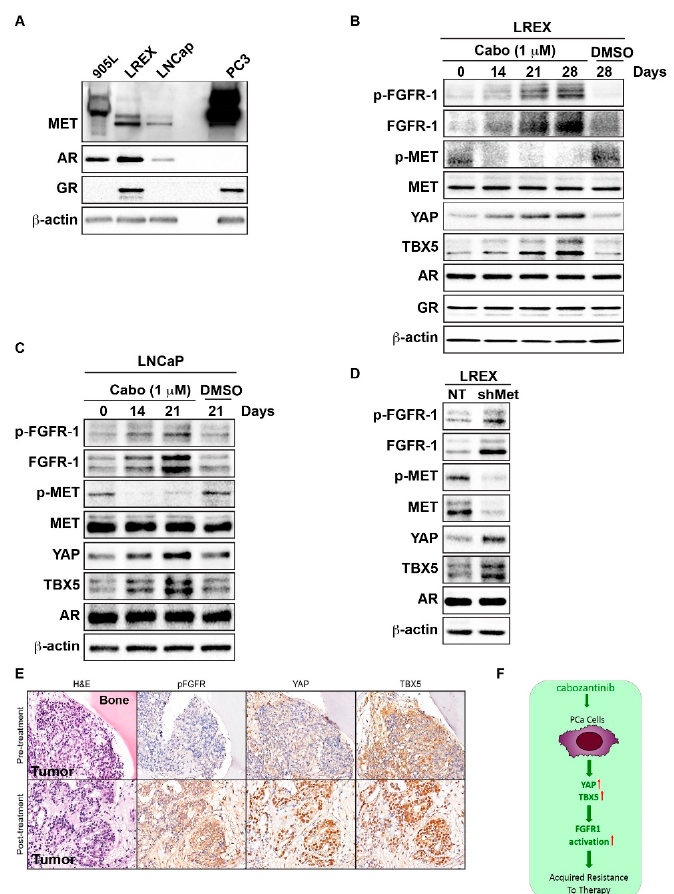
Figure 5. MET inhibition is associated with increased phosphorylation of FGFR1 and increased YAP, and TBX5 protein expression in AR-positive PCa models. ( A ) Whole-cell extracts obtained from 905L (LREX parental cell line), LREX, LNCaP, and PC3 cells were analyzed by immunoblotting for MET, AR, and GR protein expression. ( B ) LREX cells were treated with cabozantinib, and the e ff ect on MET and FGFR1 activity and YAP, TBX5, AR, and GR expression was examined. Immunoblot analysis of cell lysates was performed on control cells and at 14, 21, and 28 days of treatment at indicated cabozantinib concentration. ( C ) LNCaP cells were treated with cabozantinib and the e ff ect on MET and FGFR1 activity and YAP, TBX5, and AR expression was examined. Immunoblot analysis of cell lysates was performed on control cells and at 14, 21, and 28 days of treatment at indicated cabozantinib concentration. ( D ) Immunoblot of LREX, NT-transfected, and sh-met–transfected cells. ( E ) E ff ect of cabozantinib on pFGFR, YAP, and TBX5 expression in human PCa tumors. H&E staining and immunohistochemical evaluation of pFGFR, YAP and TBX5 expression in matched samples (trans-iliac bone marrow biopsies) from a patient with prostate cancer, obtained at baseline and after six weeks under cabozantinib treatment. ( F ) Schematic representation summarizing our findings on the molecular mechanism of resistance to cabozantinib. More details of western blot, please view at the supplementary